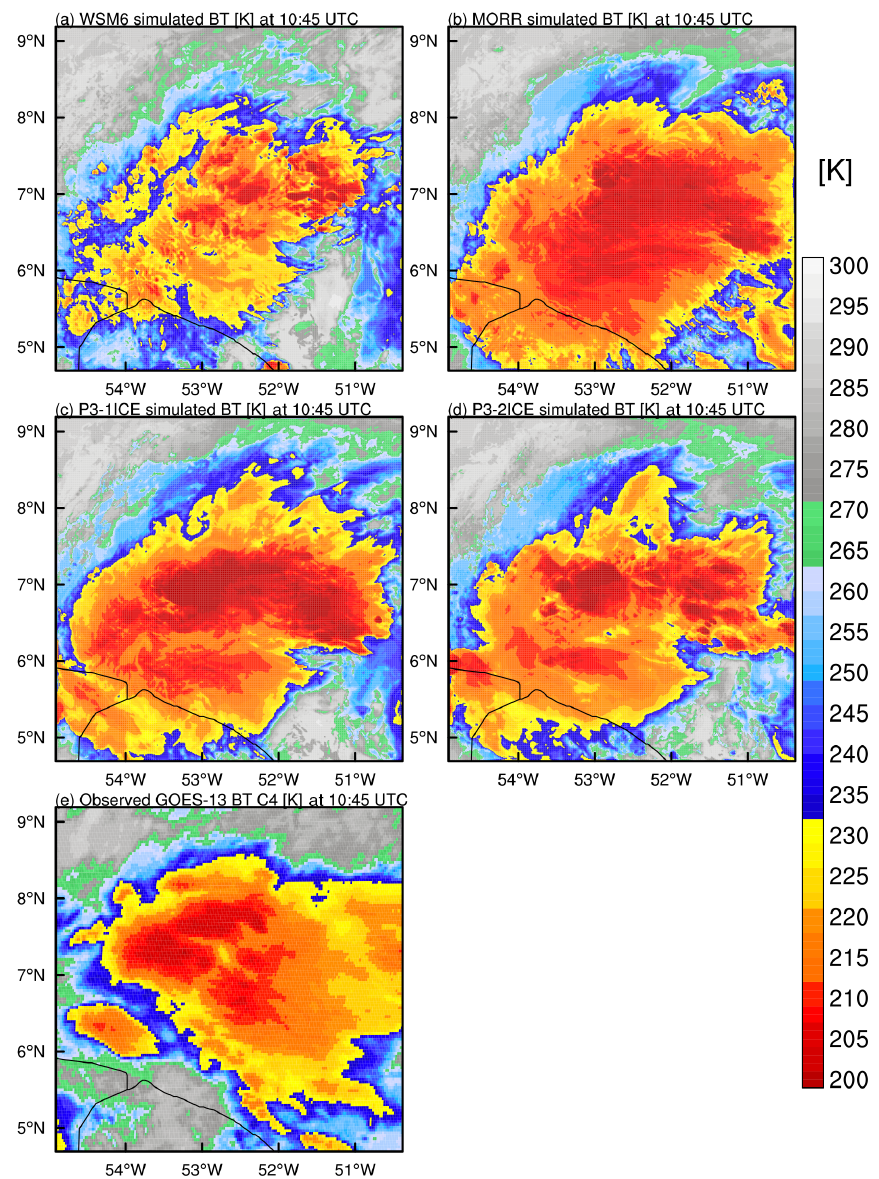
Figure 4. Simulated and observed brightness temperature (BT, K, shaded) from GOES-13 channel 4 (10.8µm) at 10:45UTC on 26 May